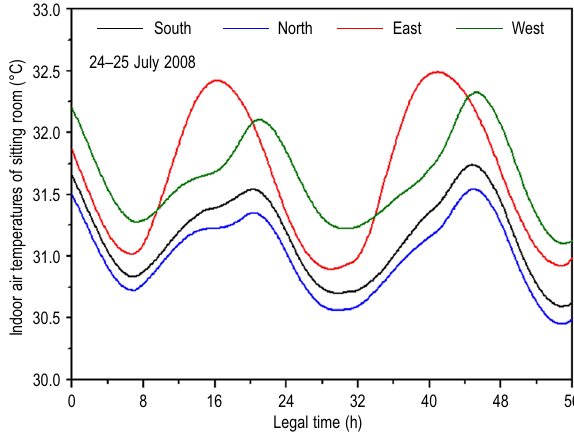
Fig. 11. Sitting room temperatures for an ordinary plane in the case of stone, S/V ratio = 0.1977, July 24 and 25, 2008